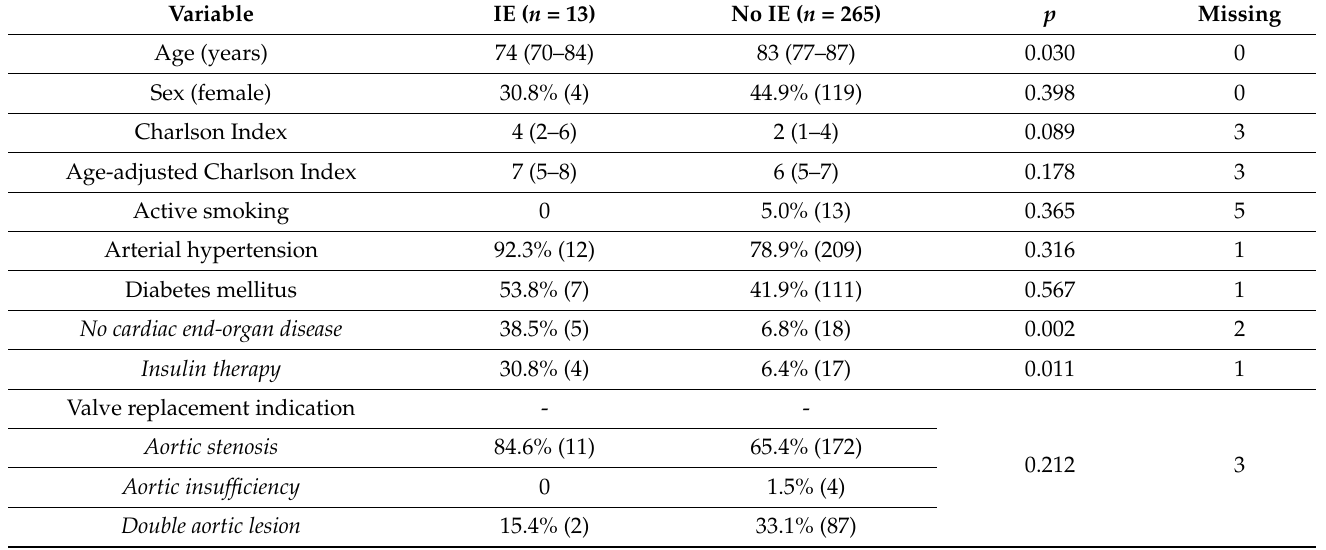
Table 3. Factors associated with IE among patients with TAVI. IE: Infective endocarditis. TAVI: transcatheter aortic valve implantation. COPD: Chronic obstructive pulmonary disease. CIED: Cardiac implantable electronic device. GFR: Glomerular filtration